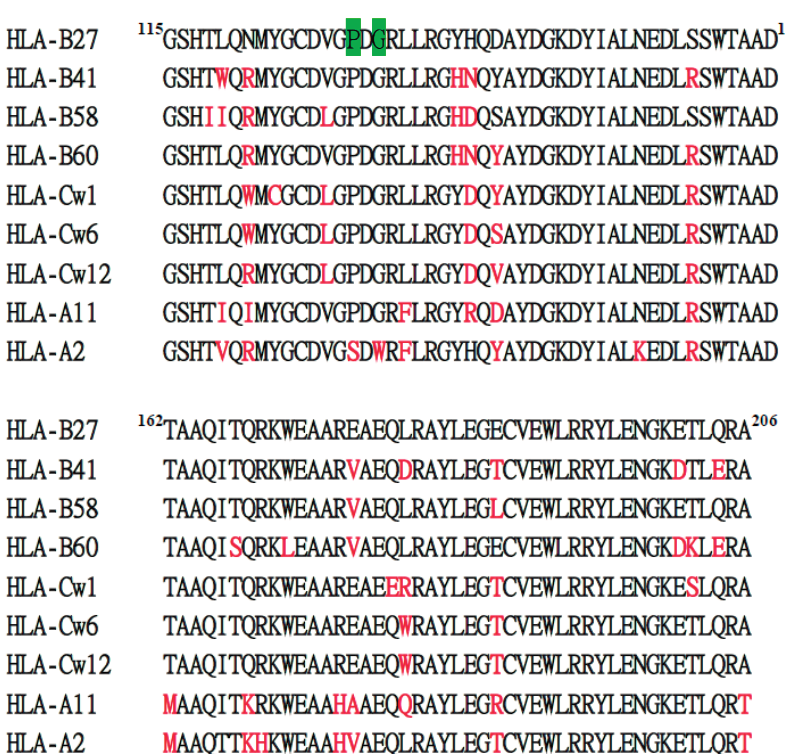
Figure 2. Analysis of HLA-B27 heavy chain domain recognized by BH2. ( A ) SDS-PAGE analysis of HLA-B27 domains overexpressed in E. coli (BL21 DE3); ( B ) Domain of HLA-B27 heavy chain recognized by BH2 was analyzed by western blotting. An aliquot (20 µg) of each crude protein extracted from E. coli bacteria that have overexpressed the indicated domain of HLA-B27 HC was separated by SDS-PAGE (15%) and analyzed by western blotting using BH2 monoclonal antibody.